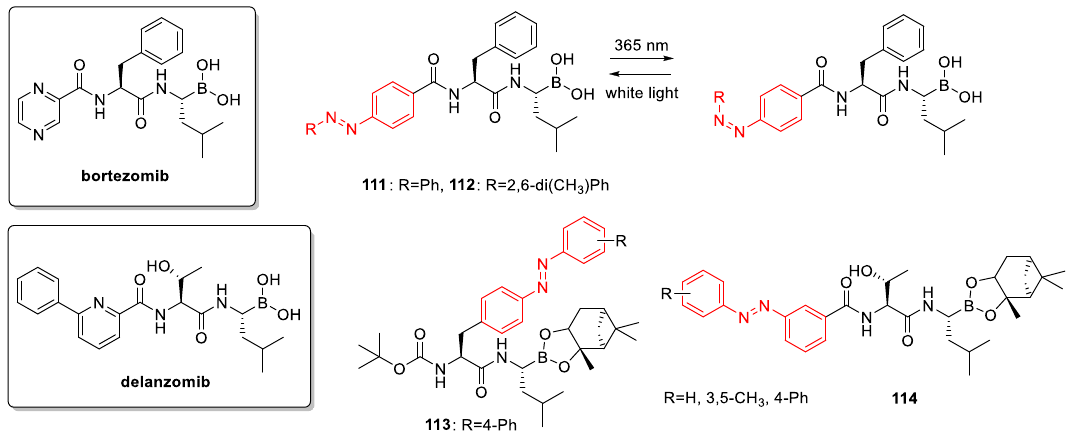
Figure 19. Photoswitchable proteasome inhibitors, the photoswitch unit indicated in red.